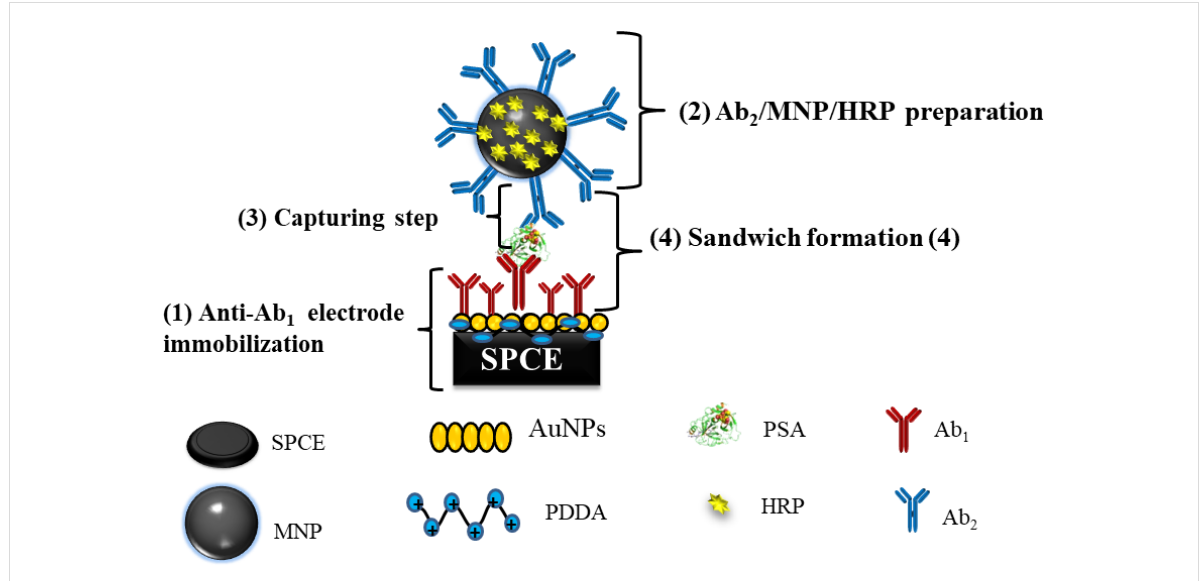
Figure 6: Schematic illustration of the fabrication of sandwich-type electrochemical immunosensors (IN μ -SPCEs).